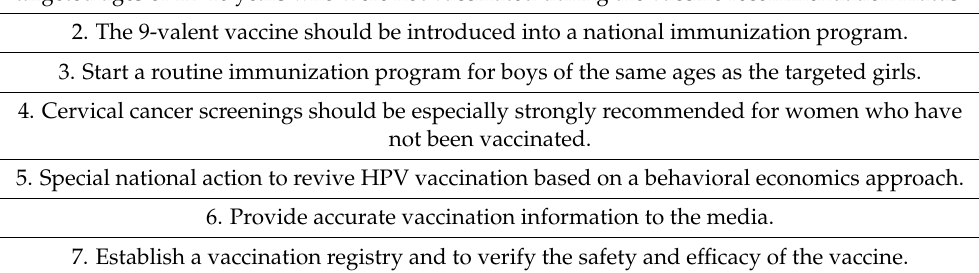
Table 2. Issues which the MHLW should be